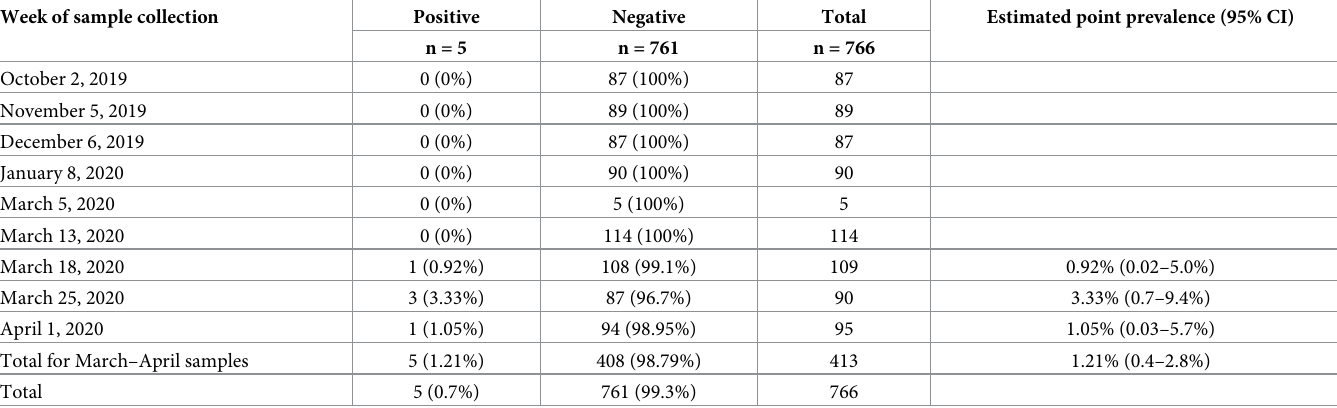
Table 1. Proportion of specimens testing positive for SARS-CoV-2 antibodies via ELISA assay by week of specimen collection. Week of sample